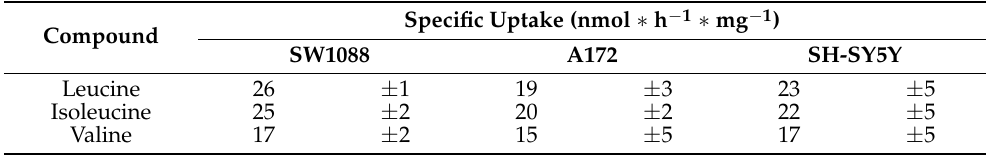
Figure 1. Representative spectra of branched-chain amino acids (leucine, isoleucine, and valine); ( a ), 2-oxoisovalerate ( b ) and acetone ( c ) of culture media consisting of DMEM supplemented with 10% FBS before (black) or after incubation of glioma (blue), glioblastoma (green), and neuroblastoma (red) cells for 24 h obtained by 1 H-NMR spectroscopy. The ranges of chemical shifts ( δ ) with peaks for all three BCAAs ( a ); 2- oxoisovalerate ( b ) and acetone ( c ) are depicted. Table 3. Branched-chain amino acid removal capability of human glioma (SW1088; n = 6), glioblas- Concentrations of leucine, isoleucine, and valine in the media were estimated from 1 H-NMR spectra by a method of external standards. Data are presented as the mean ±